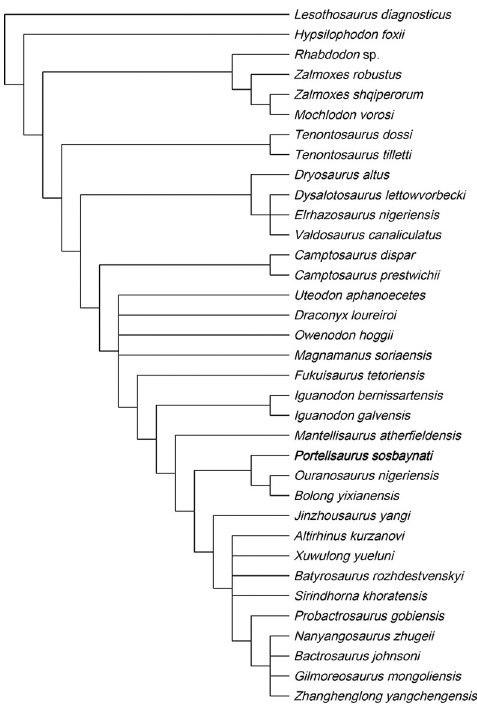
Fig 9. Phylogenetic relationships of Portellsaurus sosbaynati gen. et sp. nov. Strict reduced consensus obtained after running the IterPCR script in the MPTs from unordered dataset.